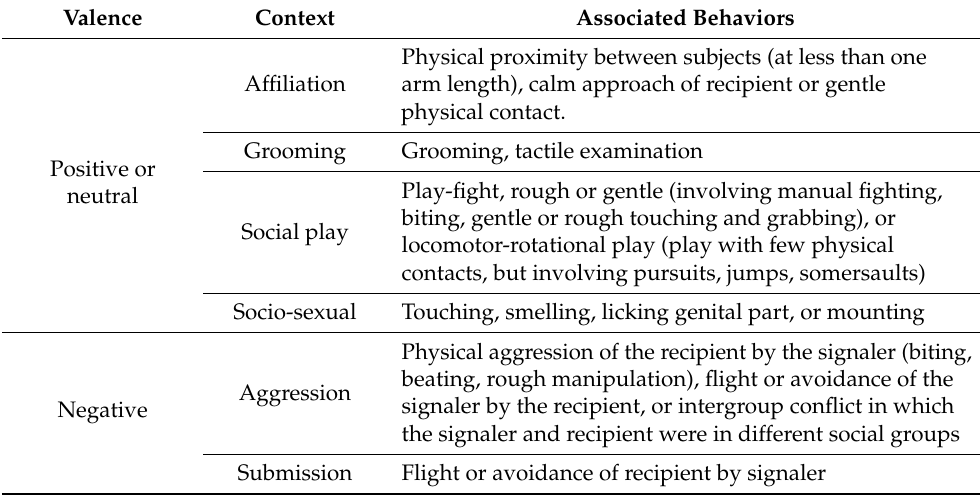
Table 2. Social contexts of gestures (adapted from Reference